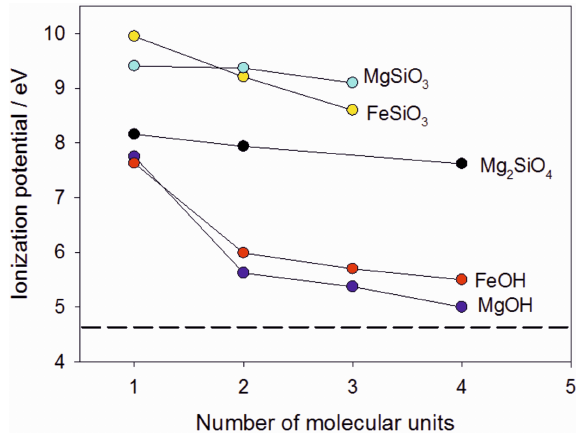
Fig. 11. Ionization potentials for a variety of Fe and Mg clusters shown as a function of cluster size, calculated at the B3LYP/6- 311+g(2d,p) level of